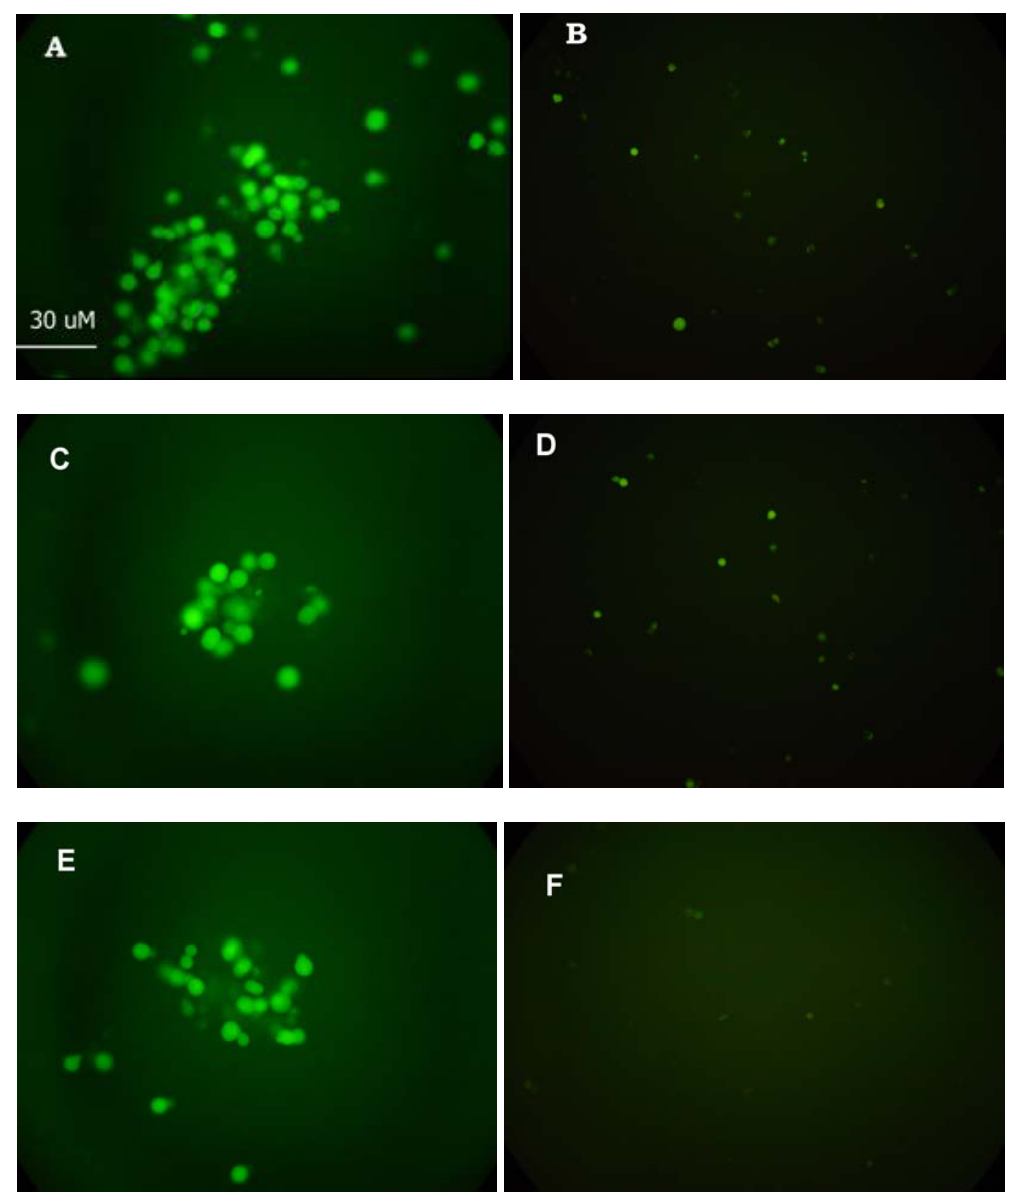
Figure 5. Changes (expressed as differences in fluorescence intensity) of the cytoplasmic calcium ion concentration in Vero cells, membrane-engineered with anti-HBs (A, B), anti- HBe (C, D) and HBsAg (E, F), before (A, C, E) and after (B, D, F) treatment with the HBsAg, HBeAg and anti-HBs